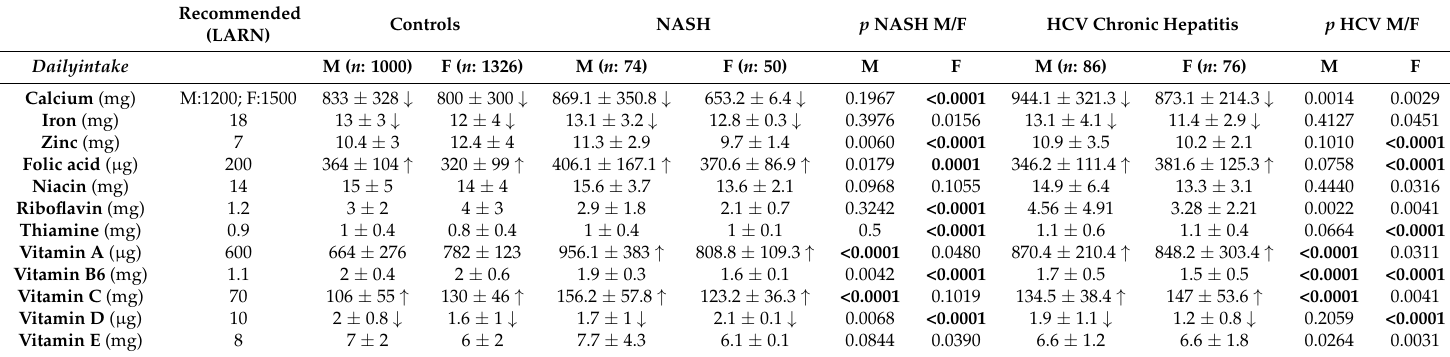
Table 5. Intake of micronutrients in study population ( ↓↑ indicate variations in respect to amounts recommended in Italy) (Mean ±